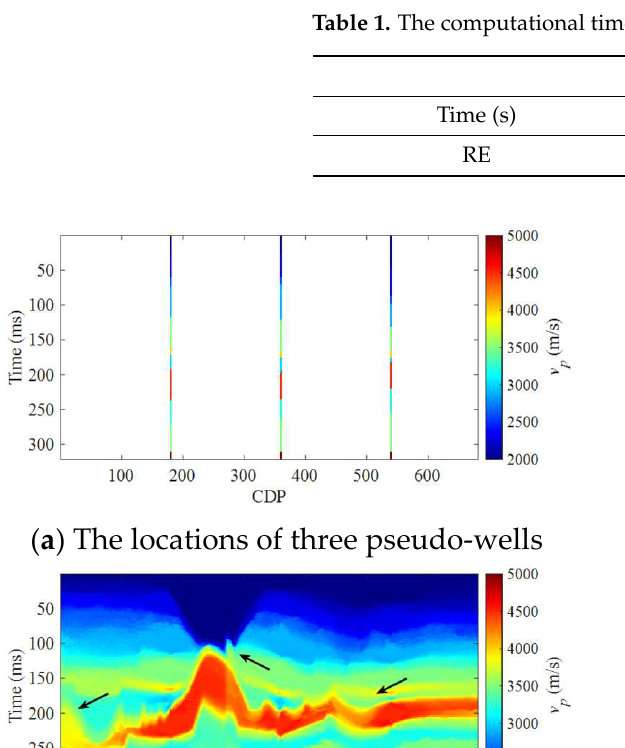
( d ) Feature-map guided NLM interpolation result Figure 7. The interpolation results from clean seismic record. Then, the noisy poststack seismic records with snr = 2 shown in Figure 5d is used for initial model building. The interpolated results with three wells by KI and FM-NLM are shown in Figure 8c,d. Compared with the KI result, the FM-NLM interpolation result holds accurate amplitude var- iation, especially for the high-velocity salt dome, because KI interpolation is conducted based on the noisy observed seismic record. In contrast, FM-NLM utilizes the extracted feature maps from dic- tionary learning. Dictionary learning as an efficient denoising algorithm can preserve useful signal from noisy observed data. We test the influence of the number of wells and hyper-parameters for interpolation. Figure 9 shows the RE of interpolated results variation with hyper-parameter h , the